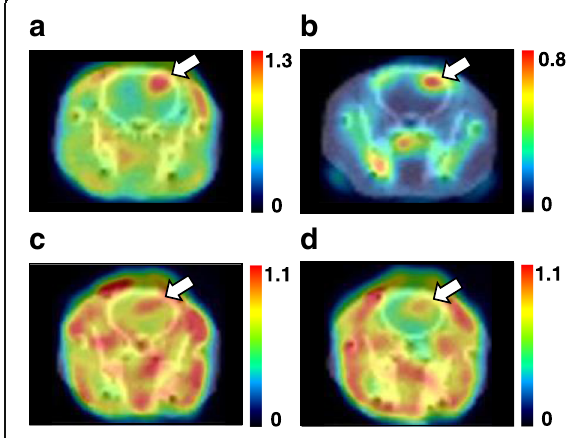
Fig. 2 PET imaging using L- and D- 18 F-FBPA ( a , b ) and L- and D- 11 C-CMT ( c , d ) in C6 glioma-bearing rat brains. Rats anesthetized by isoflurane were positioned prone on a fixation plate. After a transmission scan for 15 min, 10 MBq of each PET probe was intravenously injected, and an emission scan was performed for 90 min with 18 F-FBPA or for 60 min with 11 C-CMT. Summation images from 60 to 90 min for 18 F-FBPA and from 30 to 60 min for 11 C-CMT were reconstructed, and SUV images were created normal tissues 40 min and more after the injection (Fig. 3c, d).